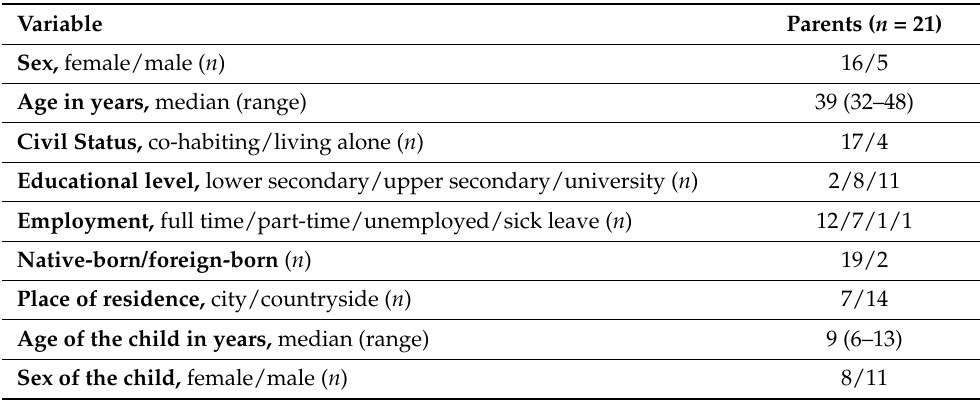
Table 1. Sociodemographic data of parent participants in the study experiencing how sleep influenced the health of their children with ADHD ( n =